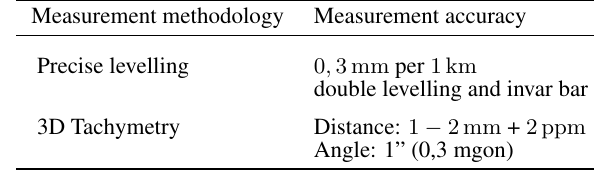
Table 1. Comparison of the measurement accuracy of devices used for gathering the ground truth deformation data on the test building (Burland et al.,